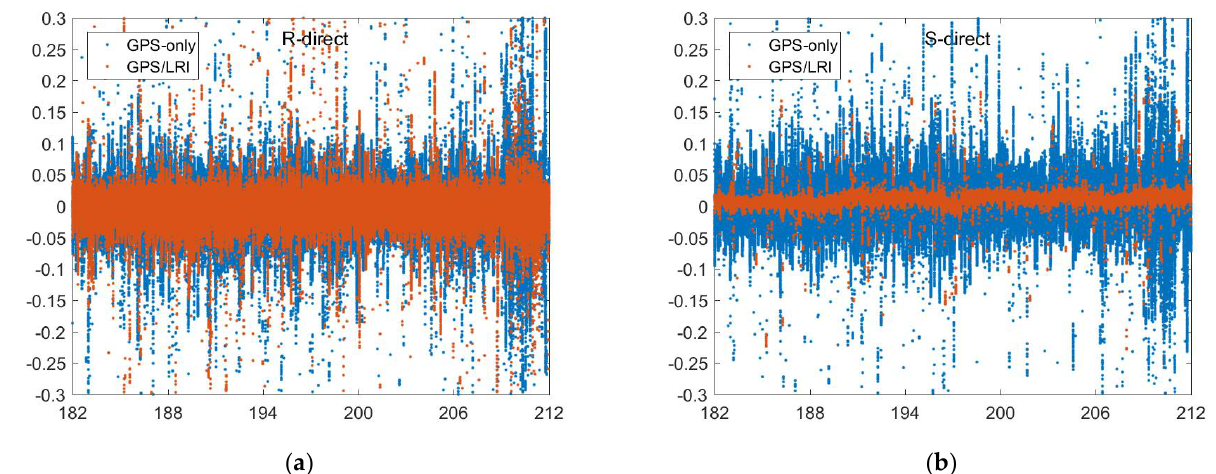
Figure 8. Reference orbit check for GRACE-FO-A in the R, S, W, 3D directions (days 151-182, ( a – d )).